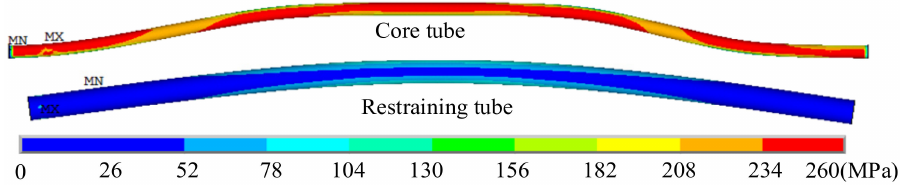
Figure 19. Stress distribution in point-contact state.